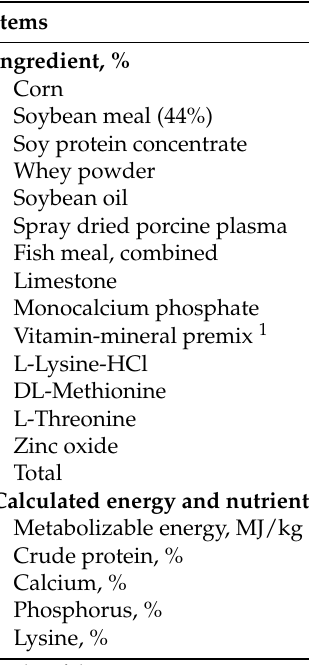
Table 1. Ingredient composition of basal diet for weaned pigs (as-fed